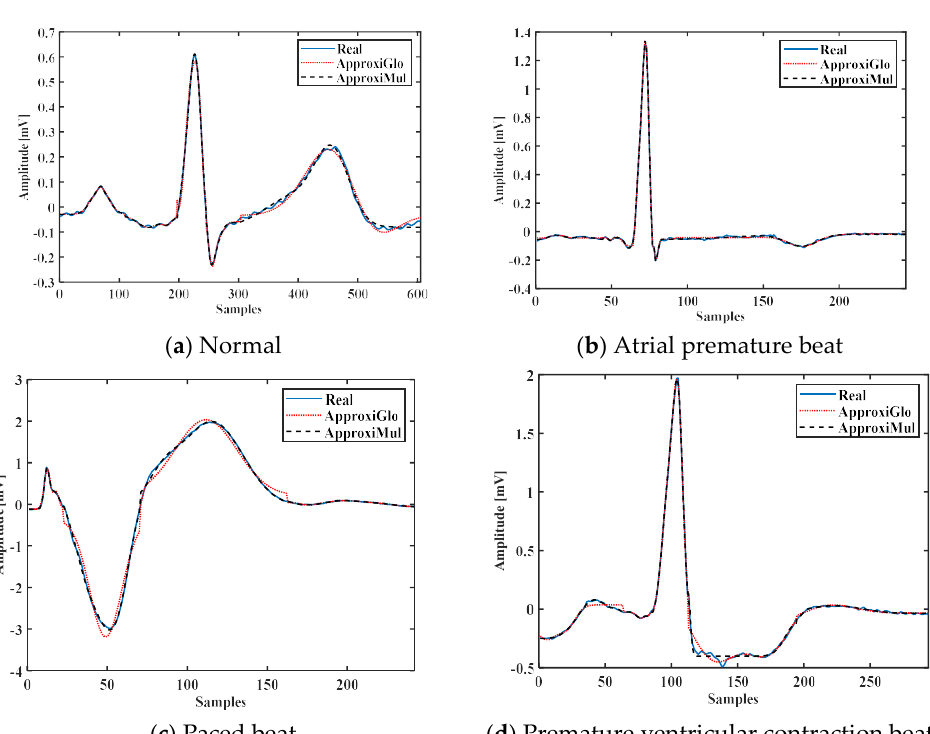
Figure 5. Model fitting of different cardiac dysrhythmias which are morphologically different and have different pathophysiological conditions.